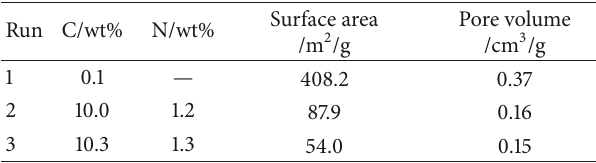
Table 5: Elemental analysis and N 2 adsorption of fresh and reused NaY